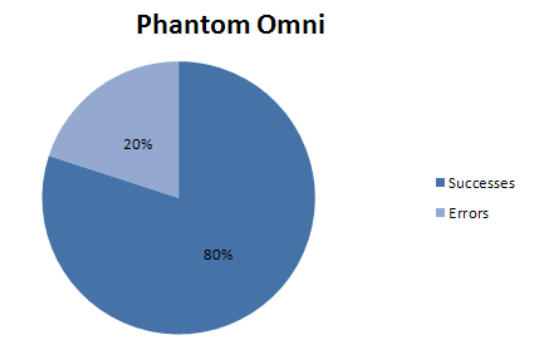
Fig. 24. Success rate in the medical procedure with a Phantom Omni.